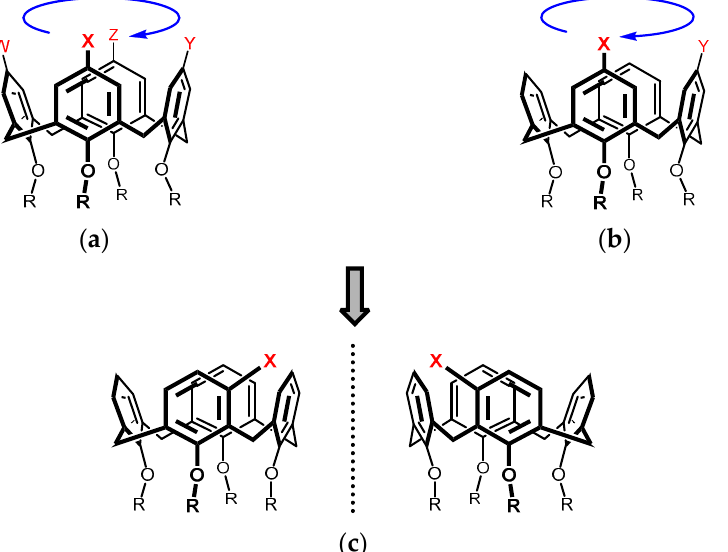
Figure 1. Examples of inherently chiral calix[4]arenes: ( a ) WXYZ pattern; ( b ) XY pattern; ( c ) meta Figure 1. Examplesofinherentlychiralcalix[4]arenes: ( a )WXYZpattern; ( b )XYpattern; ( c ) meta substitution. substitution.